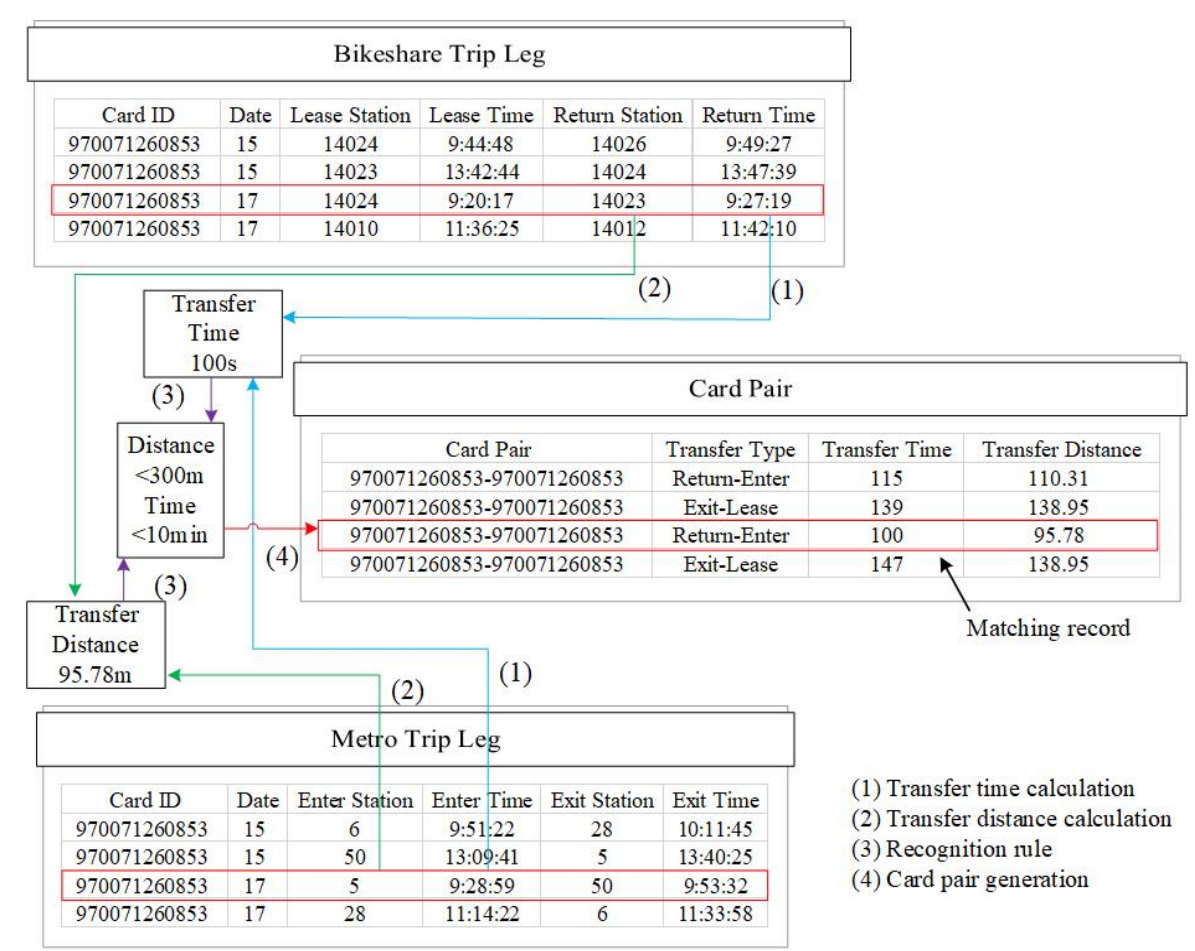
Figure 3. Process of generating Card Pair (an example using a seamless smartcard with the ID